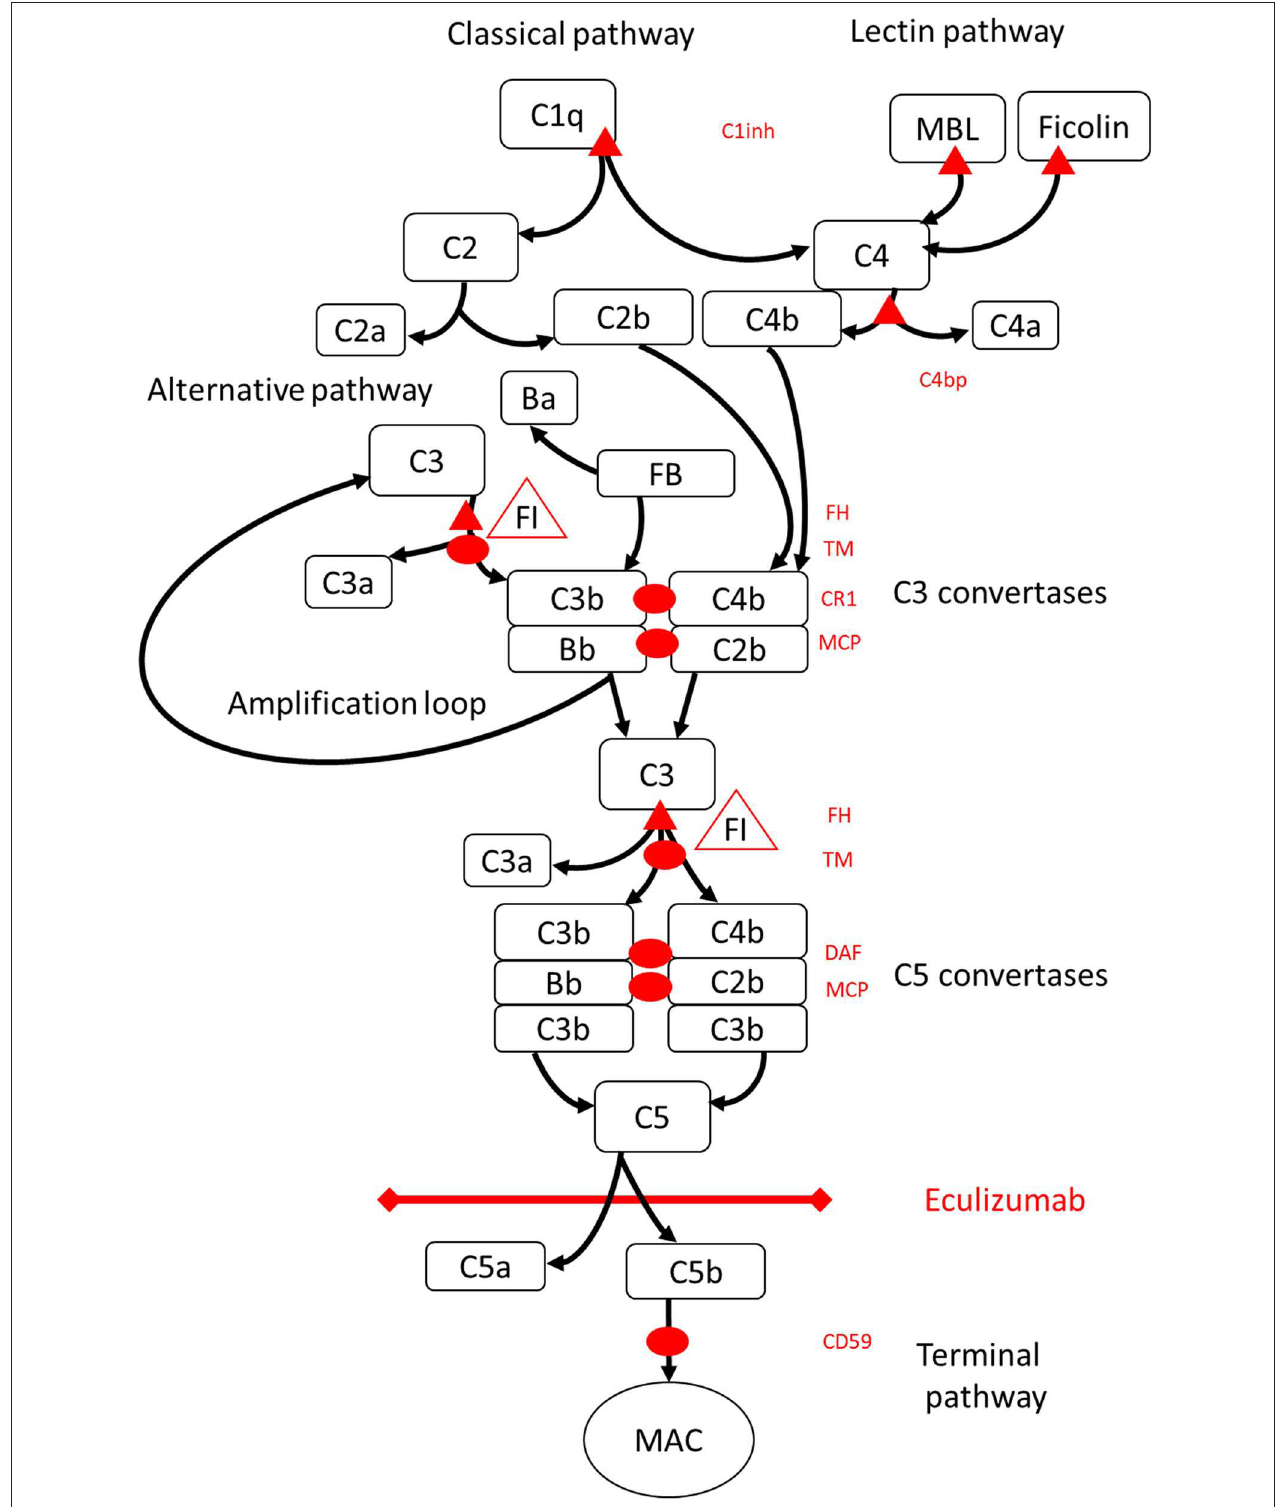
FIGURE 1 | Eculizumab inhibits terminal pathway of complement activation. Complement activation may be initiated via three pathways of activation, that all lead to the formation of C5 convertases that have the capacity to activate the terminal pathway leading to formation of the MAC on the target surface. This